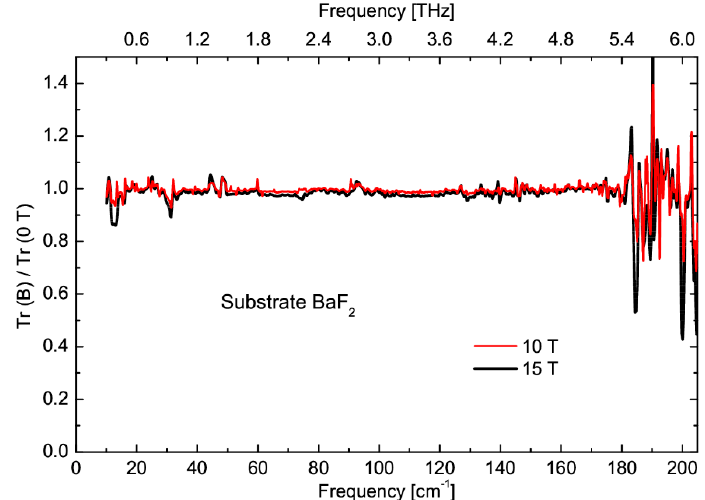
Figure 2. Frequency-dependent transmission of a bare BaF 2 substrate at 10 and 15 T normalized to its zero-field spectrum. The noise at high frequencies is due the experimental setup. The Figure is meant to demonstrate: (i) the absence of any field-induced changes in the optical spectra of BaF 2 and (ii) the frequency limits of the setup